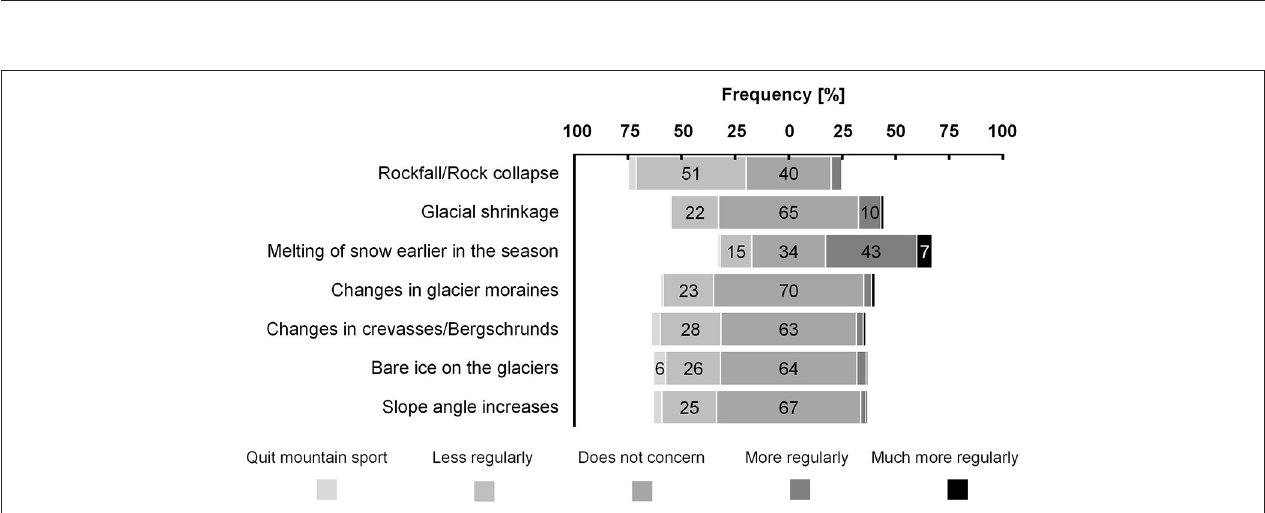
FIGURE 3 | Engagement in summer mountain sport when being confronted with consequences of climate change. No significant differences were found between groups, p > 0.143. Values below 5% were not specified.